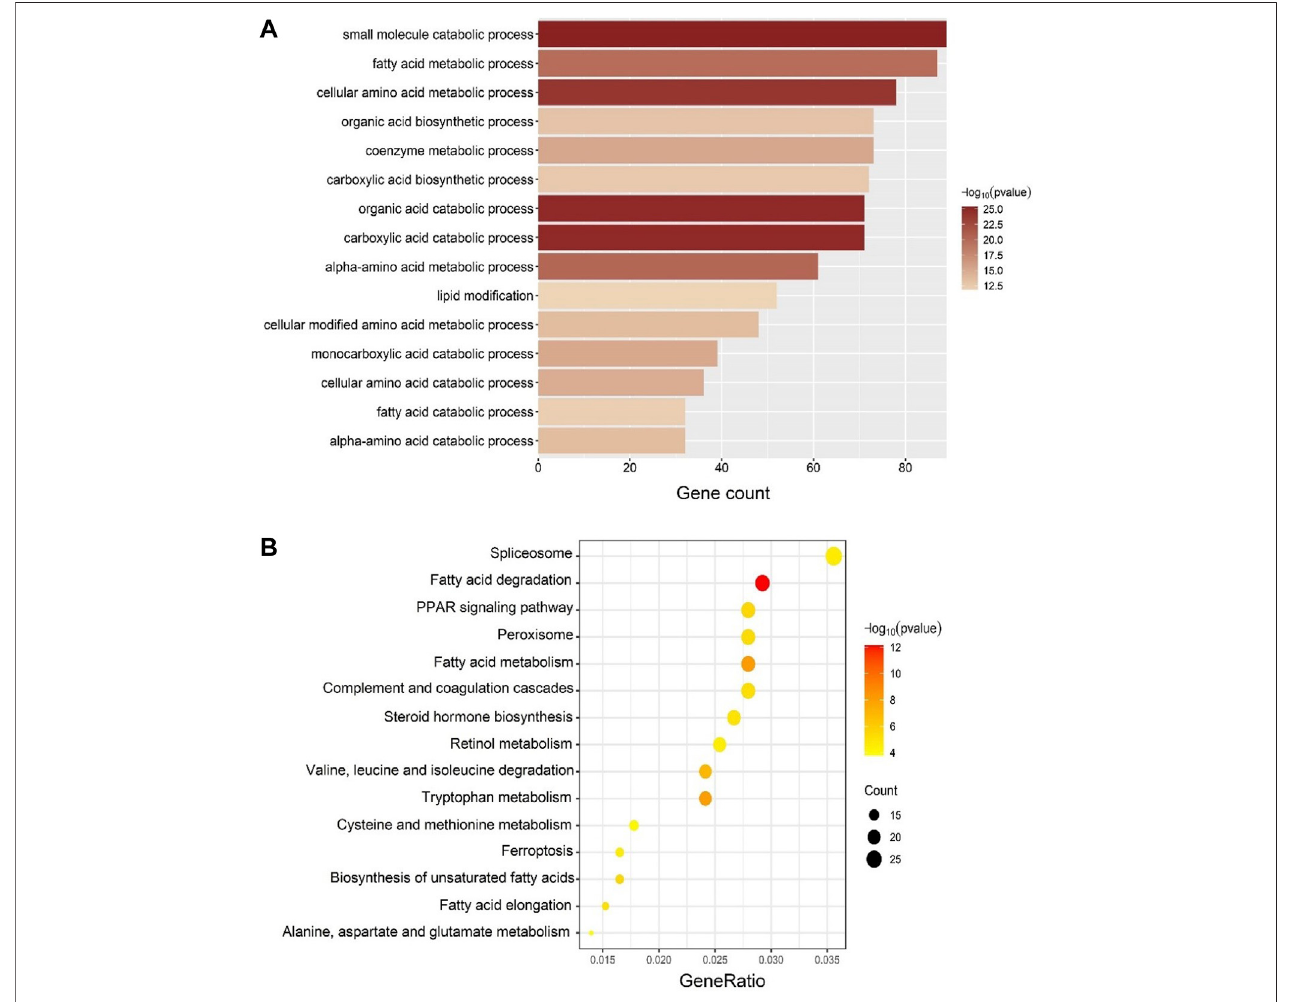
FIGURE 5 | GO and KEGG enrichment analyses in the blue module. (A) Top 15 signi fi cantly enriched GO biological process (BP) terms. The depth of color corresponds tothe enrichmentsigni fi cance ofeach term, while the x -axis representsthe gene counts. (B) Top 15signi fi cantlyenriched KEGG terms. The depth ofcolor corresponds to the enrichment signi fi cant of each term, while the size of the dots correlates with the enriched gene counts.